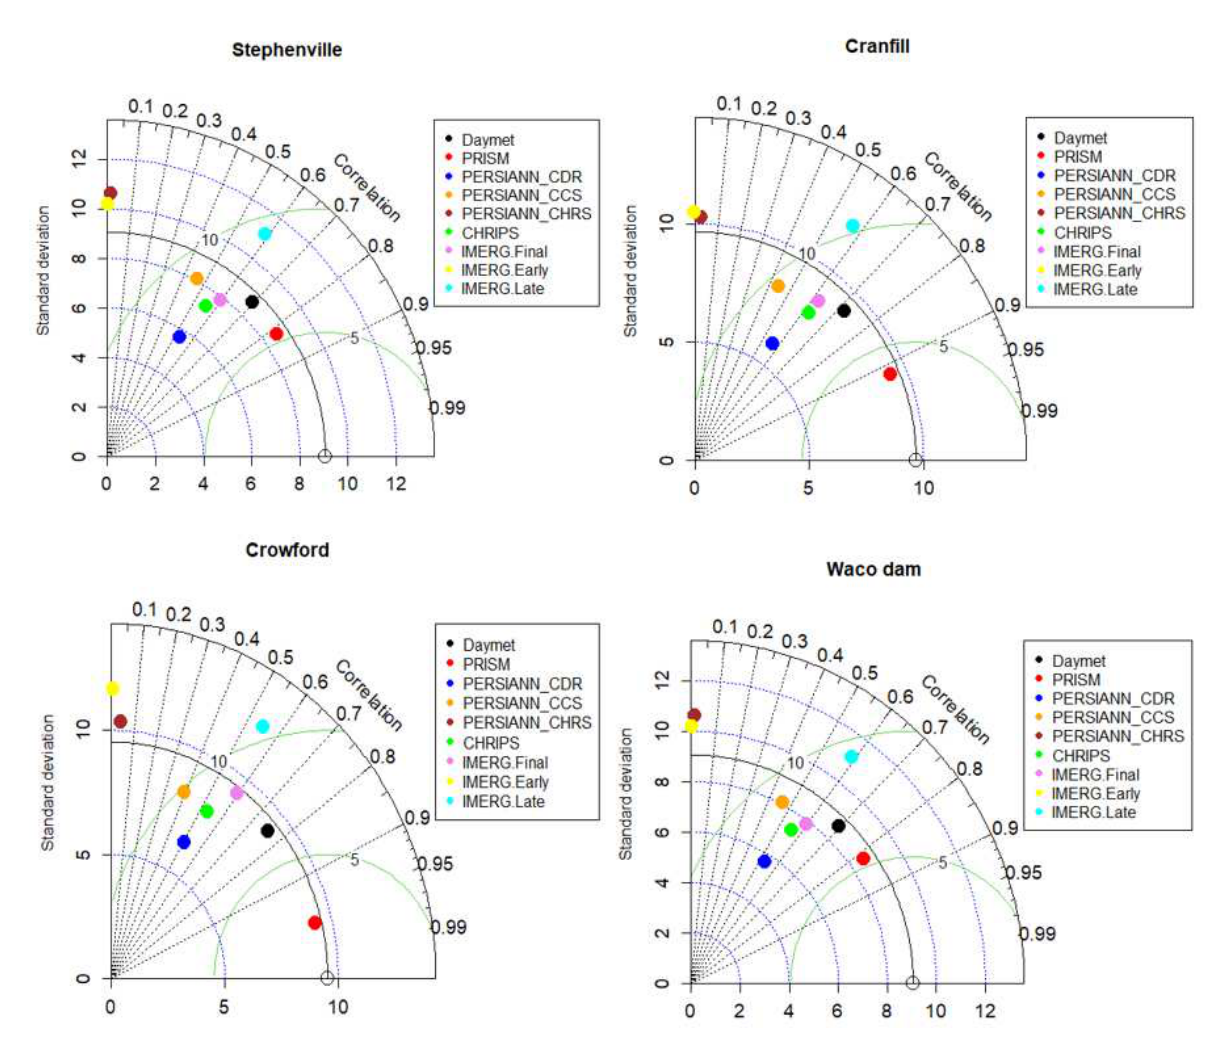
Figure 2. Taylor diagrams demonstrate the correspondence between daily in situ and gridded pre- cipitation datasets. Stephenville, Cranfill, Crowford, and Waco dam are among the climatic stations located at the upper, middle, and lower courses of the Bosque watershed (Figure 1). The green contours indicate the RMSE values, which measure the difference between the gridded datasets and in situ data proportional to the distance from the x-axis.